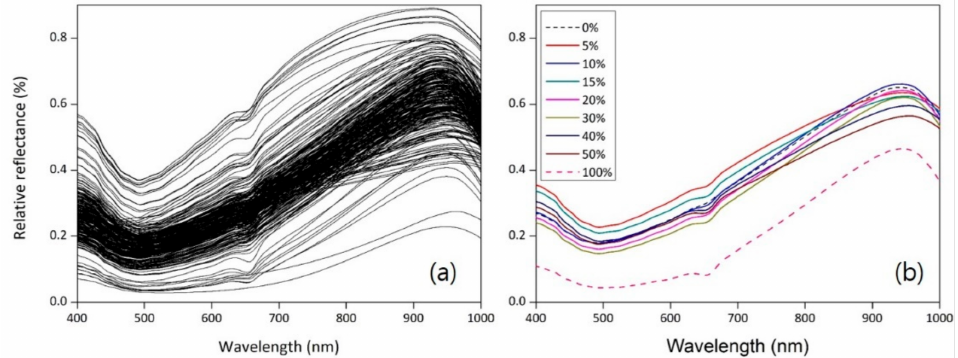
Figure 3. Spectral data of mixture samples with increasing FWC concentration (0, 5, 10, 15, 20, 30, 40, 50, and 100%): ( a ) whole and ( b ) average